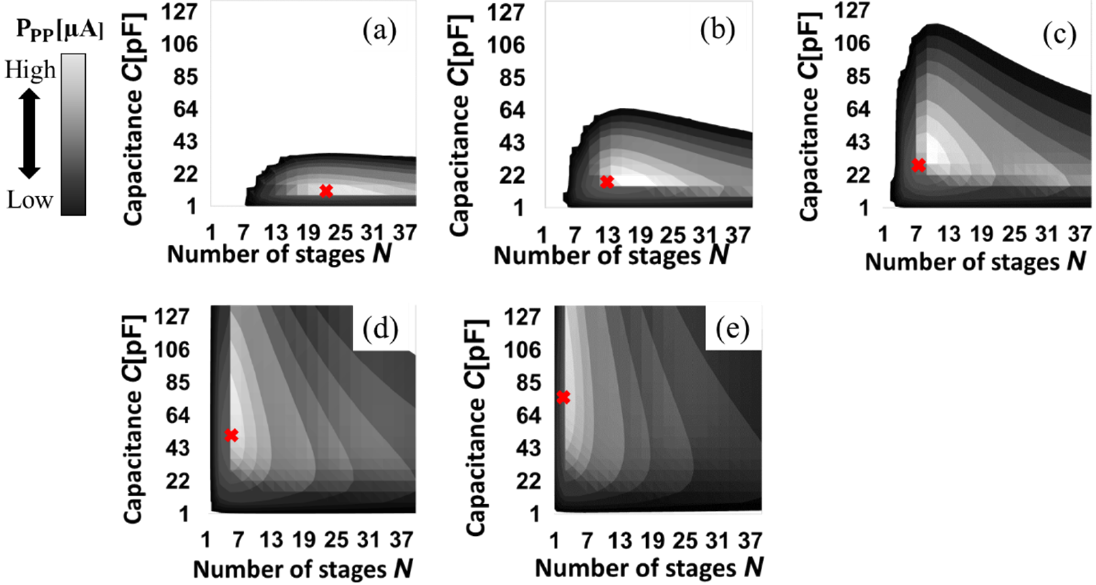
Figure 7. Contour plots of P OUT in case of V OC of 0.5 V ( a ), 0.7 V ( b ), 1.0 V ( c ), 1.5 V ( d ), and 2.0 V ( e ). “x” in each figure indicates the maximum power point.